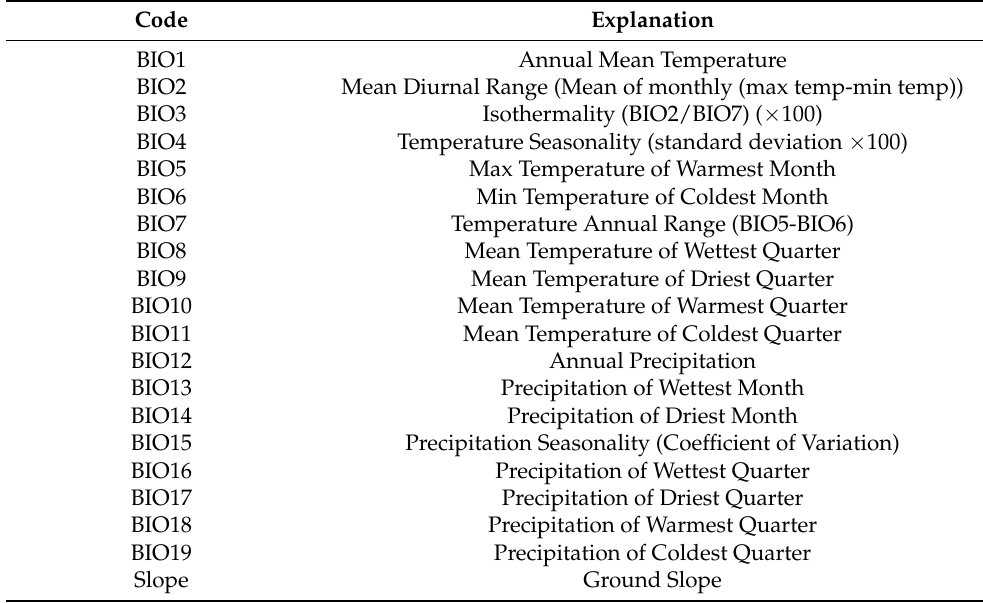
Figure A1. Correlation matrix for all environmental variables. Table A1. Detailed explanation of bioclimate variables and used input variables in the